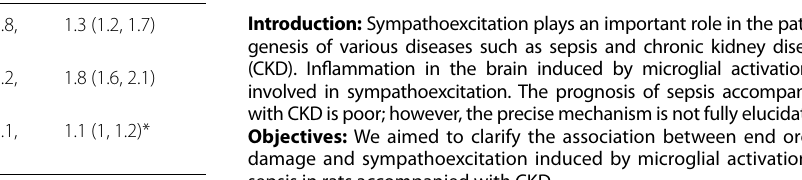
Table 2 Values of hemodynamic variables at the end of the